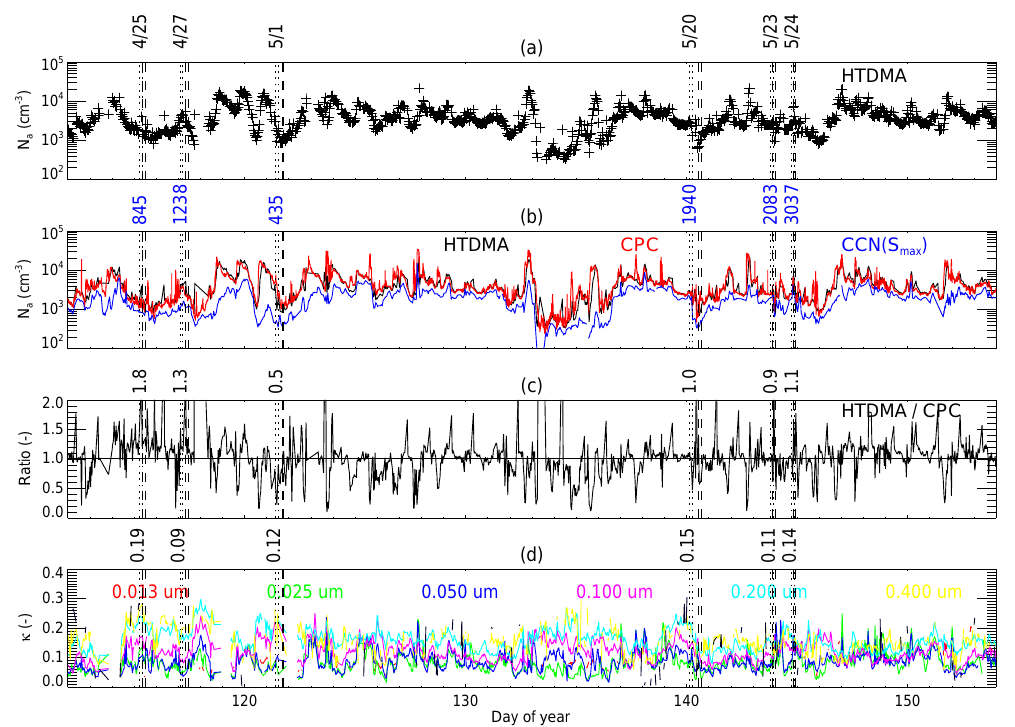
Figure 3. Ground-based aerosol properties at the central facility during MC3E: (a) total number concentration ( N a ) measured by the HT- DMA; (b) N a measured by the HTDMA, ground-based CPC, and CCN at maximum supersaturation of approximately 1%; (c) ratio of N a measured by HTDMA to that measured by ground-based CPC; and (d) hygroscopicity parameter ( κ ) measured by the HTDMA at six sizes (intermittent at smallest cut). For each case study, pairs of dashed and dotted vertical lines bound the Citation flight duration and a 2h pre-rain period, respectively; values above plots are pre-rain period averages, linearly averaged over available sizes for κ . Dates are indicated in m/dd